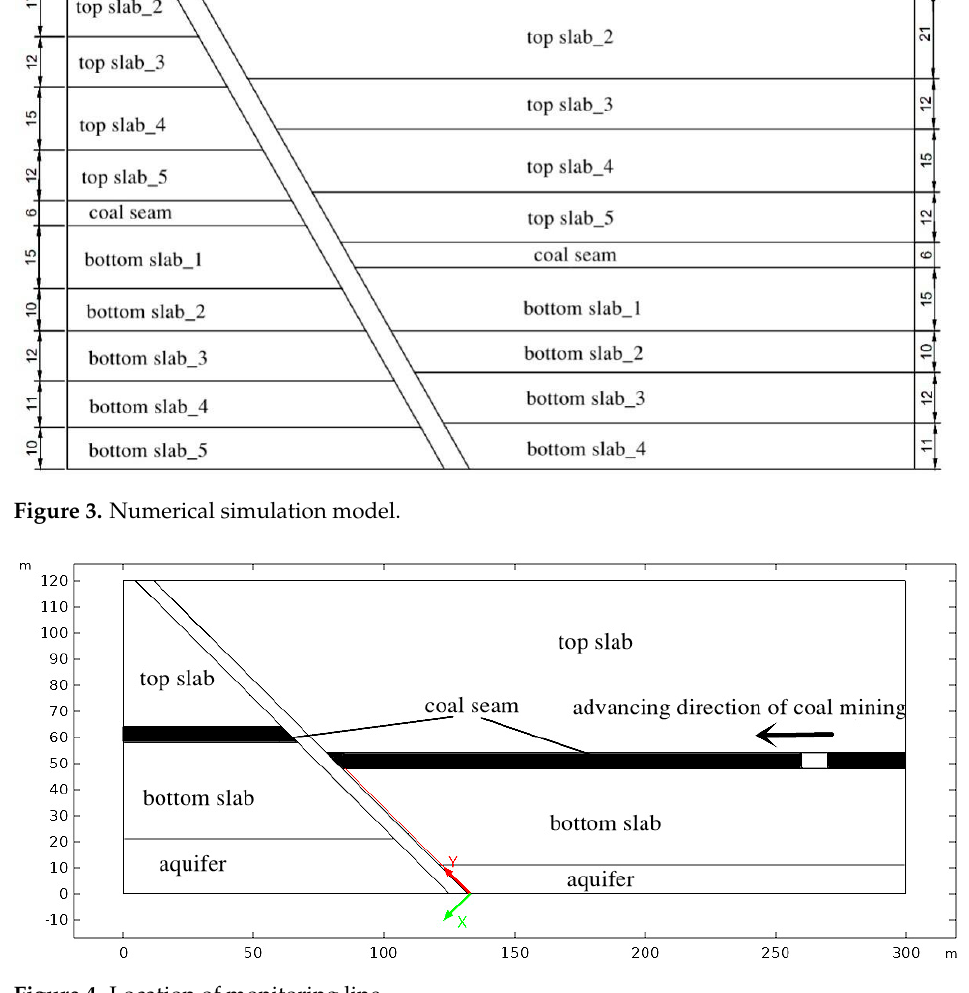
Figure 4. Location of monitoring line.